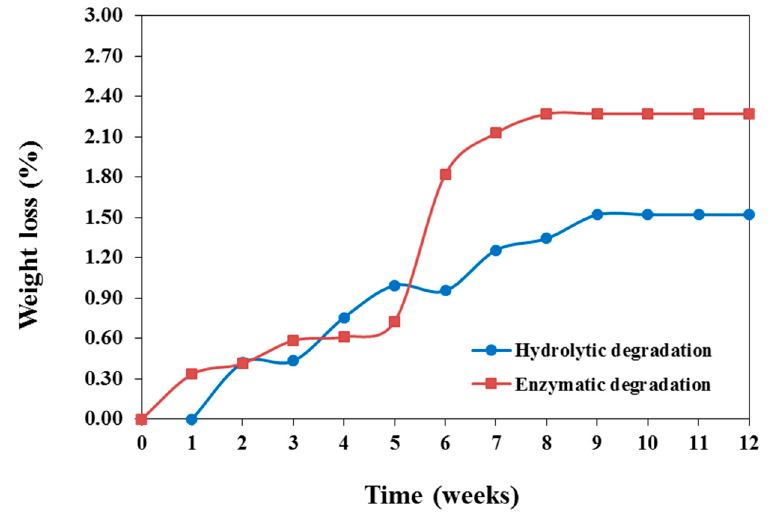
Figure 4. Weight loss percentage of PBF- co -PPOF-80/20 co-polyester along 12 weeks.